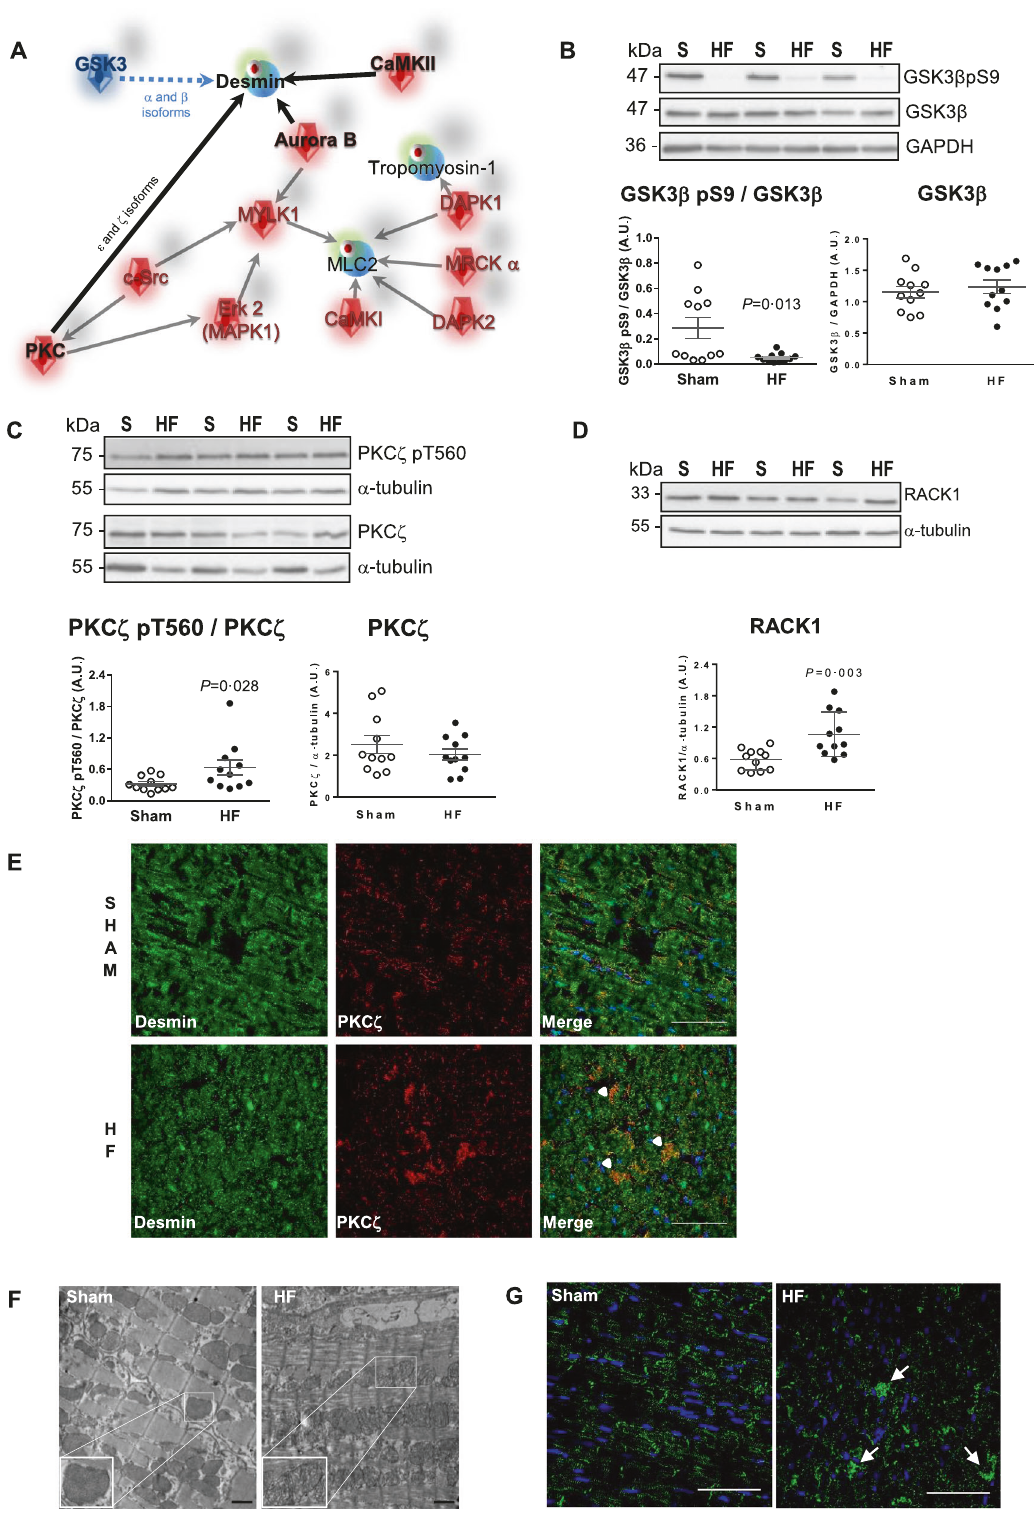
To decipher the contribution of CMA in desmin clearance in cardiomyocytes, CMA was induced by either 2 or 5 µmol/L of geldanamycin (GA) for 17 h (Fig. 4 and Fig. S6A – B) as previously described [30]. Under GA treatment, we found a signi fi